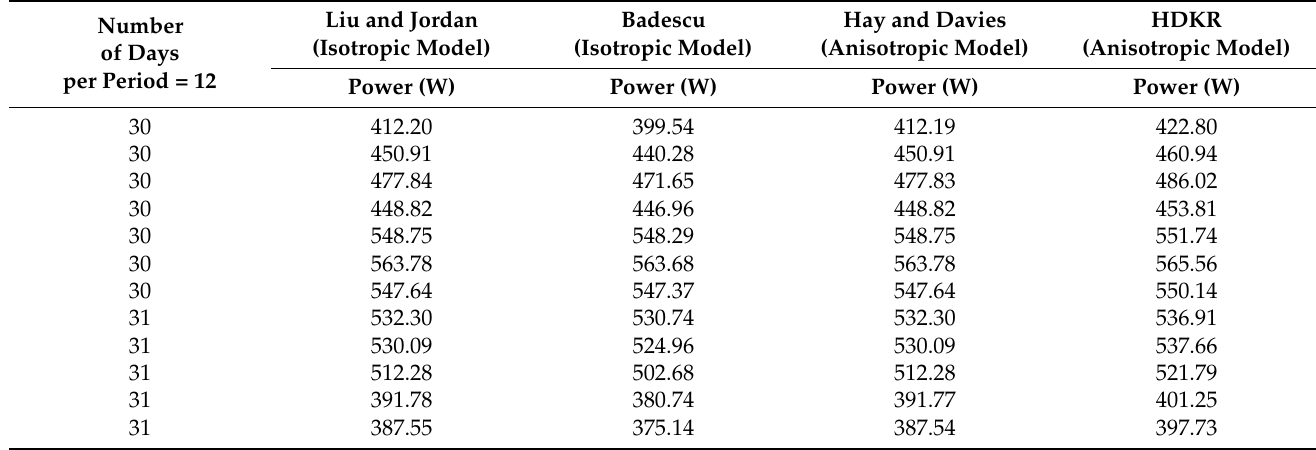
Table 3. Power output results for Dhahran city for NP =